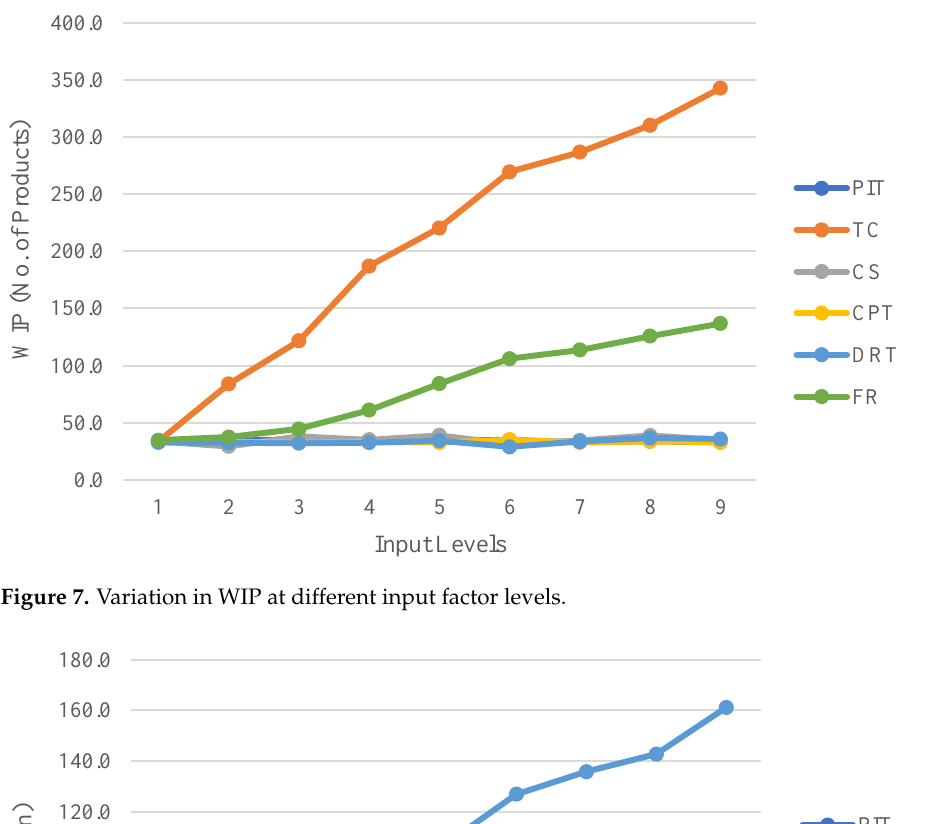
Figure 7. Variation in WIP at different input factor levels.